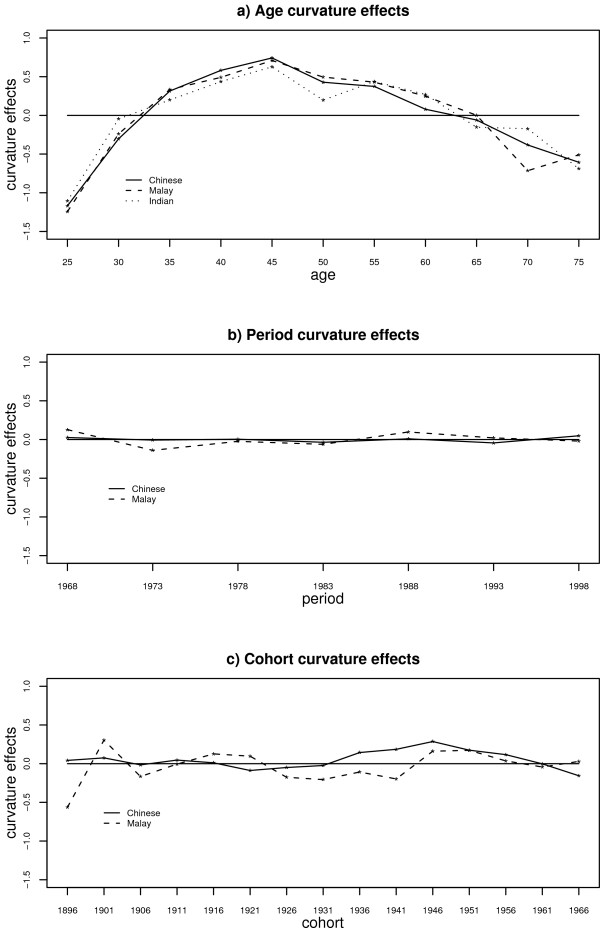
Curvature effects for a) age, b) period and c) cohort from full age-period-cohort model. (First cohort 1891–1895 and last cohort 1971–1975 are not shown as they are only based on one observation).